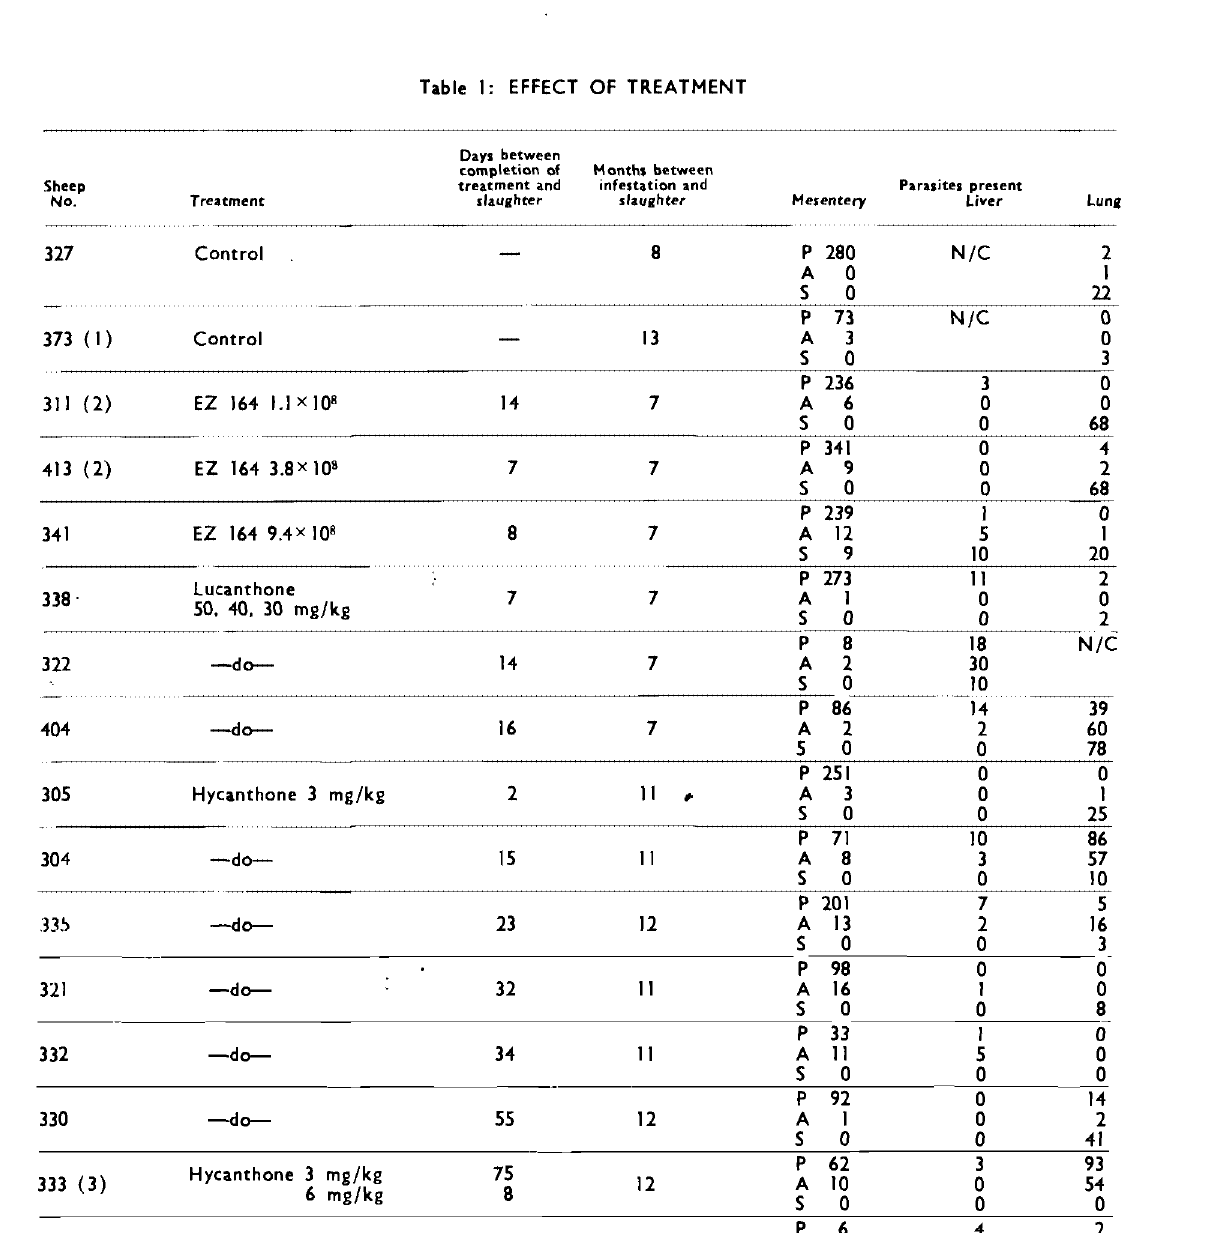
Table 1: EFFECT OF TREATMENT